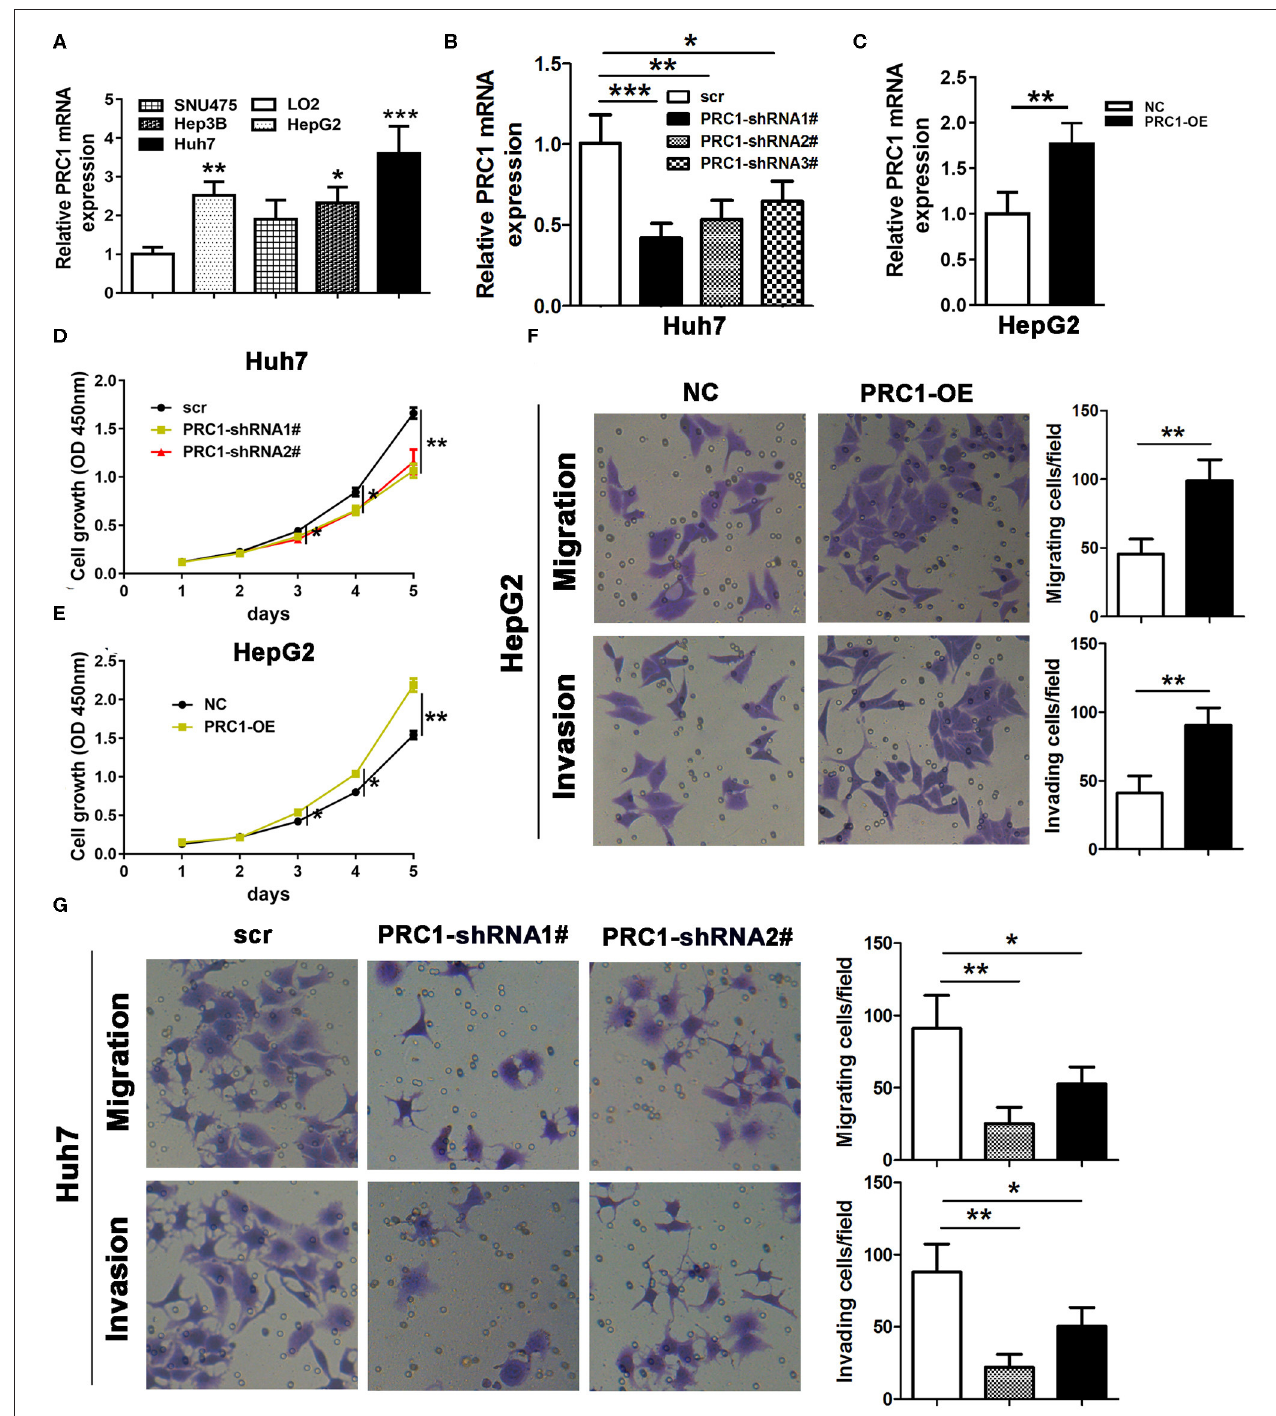
FIGURE 6 | PRC1 regulates cell growth, cell migration, and invasion. (A) qRT-PCR analysis of PRC1 expression in the hepatocellular carcinoma cell lines HepG2, SNU475, Hep3B, and Huh7 and the normal liver cell line LO2. (B) Knockdown of PRC1 (PRC1 shRNA1# − 3#) in Huh7 cells and qRT-PCR assessment of PRC1 expression. Huh7 cells were transfected with PRC1-shRNA1# or shRNA2# and HepG2 cells were transfected with PRC1. (C) Overexpression of PRC1 in HepG2 cells and qRT-PCR assessment of ZFP36 expression. (D,E) Cell growth was determined by a CCK-8 assay. (F,G) Cell migration and invasion were detected by Transwell assay, * p < 0.05, ** p < 0.01, *** p < 0.001.